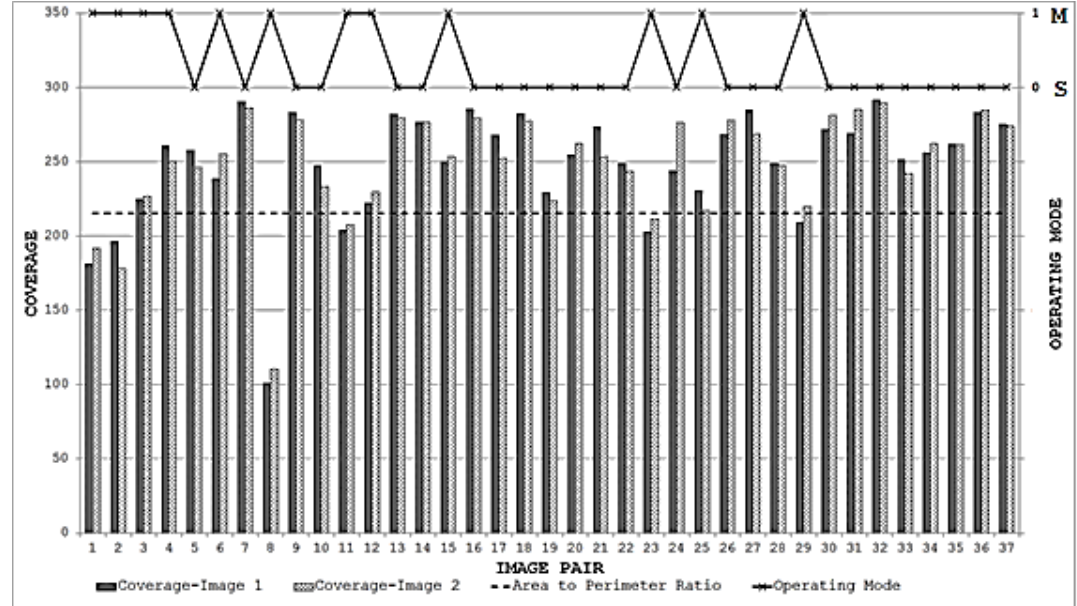
Figure 19. Coverage results achieved using the proposed framework for the